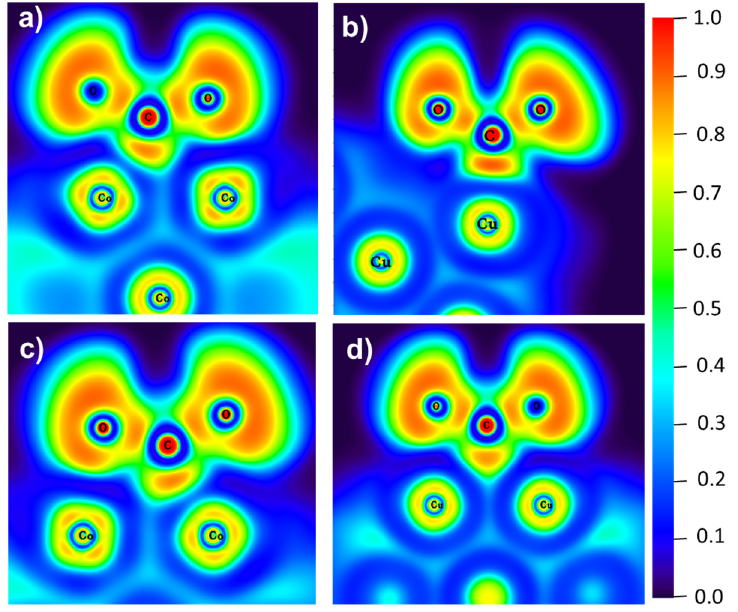
Figure 7. Electron localization function contours for: ( a ) CO 2 adsorption on Co 13 , ( b ) CO 2 adsorption on Cu 13 , ( c ) CO 2 adsorption on CO 13 /PNG, and ( d ) CO 2 adsorption on Cu 13 /PNG.